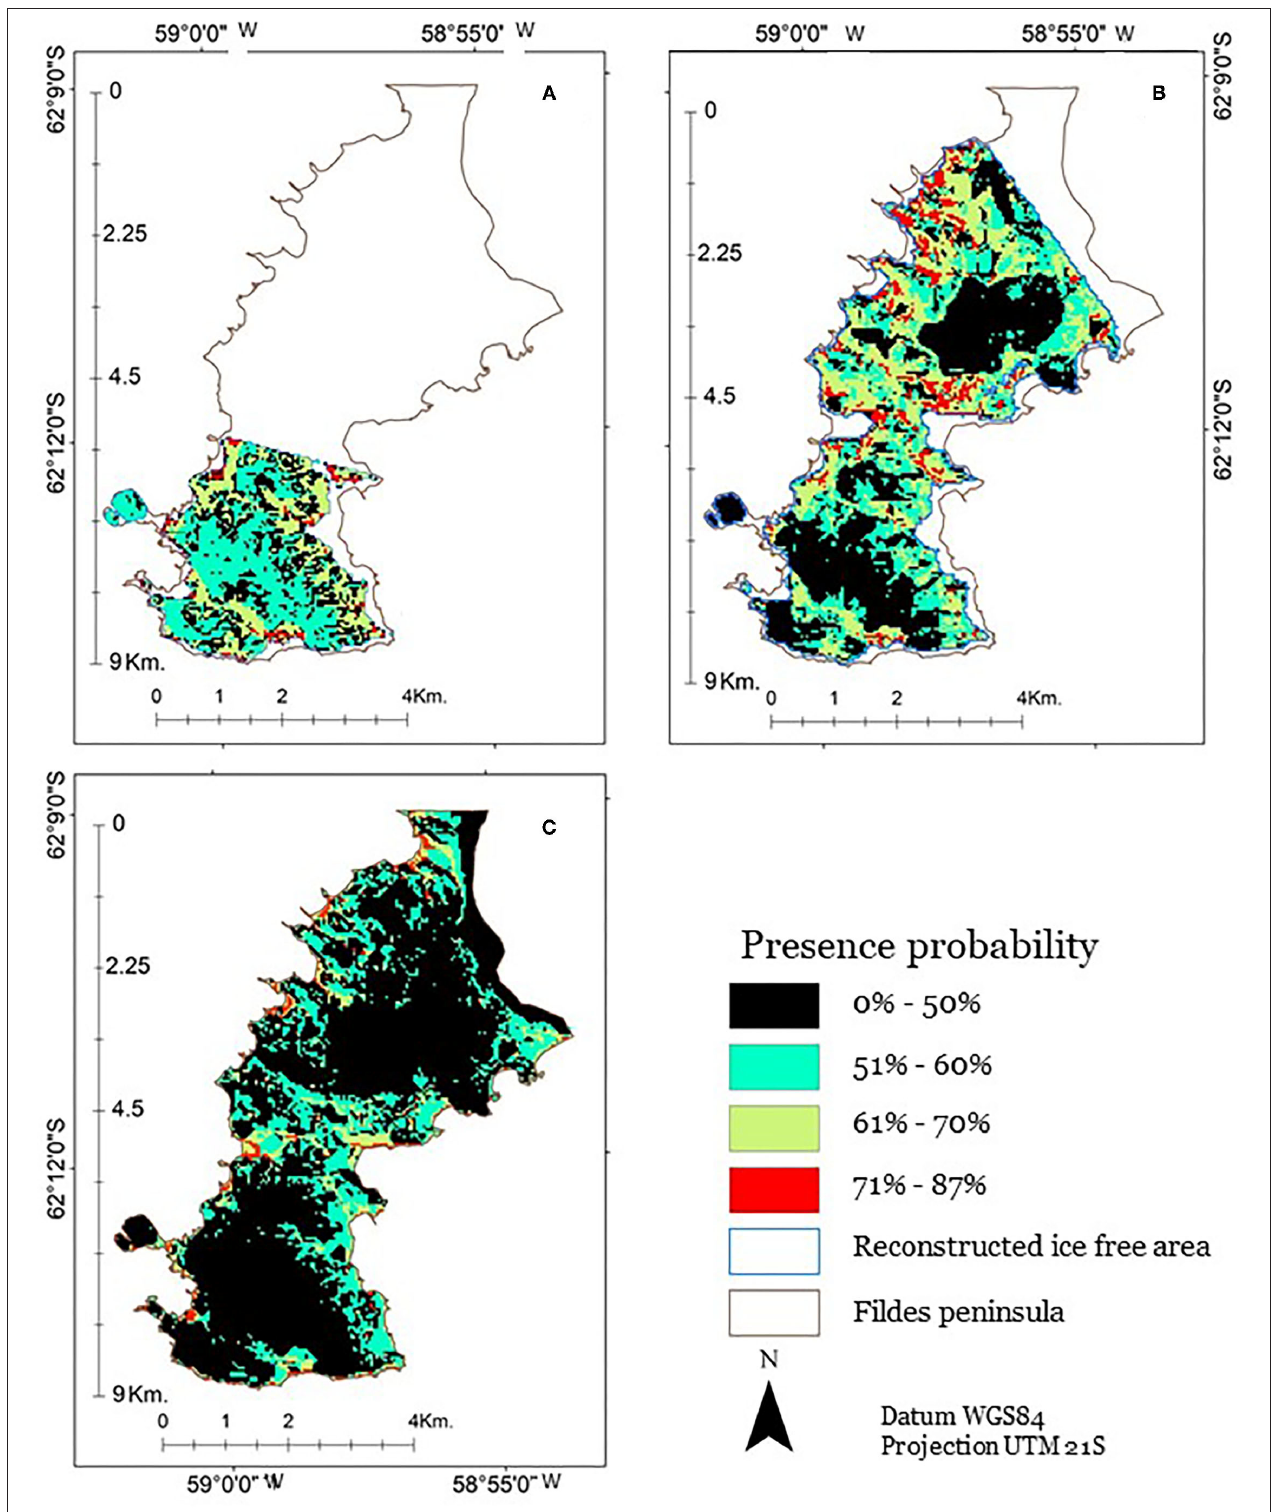
FIGURE 7 | Probability of presence of S. uncinata in the Fildes Peninsula. (A) 11 ka, (B) 6 ka, and (C) today, as modified from González et al. (2019).